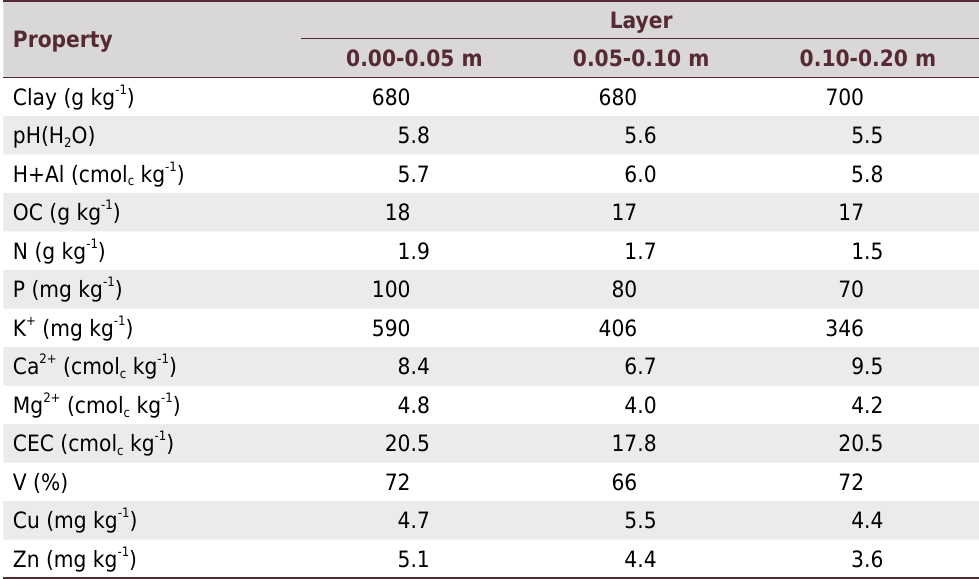
Table 1. Initial characterization of the Rhodic Kandiudox ( Nitossolo Vermelho Distroférrico ) in the 0.00-0.05, 0.05-0.10, and 0.10-0.20 m layers. Concórdia, Santa Catarina, Brazil